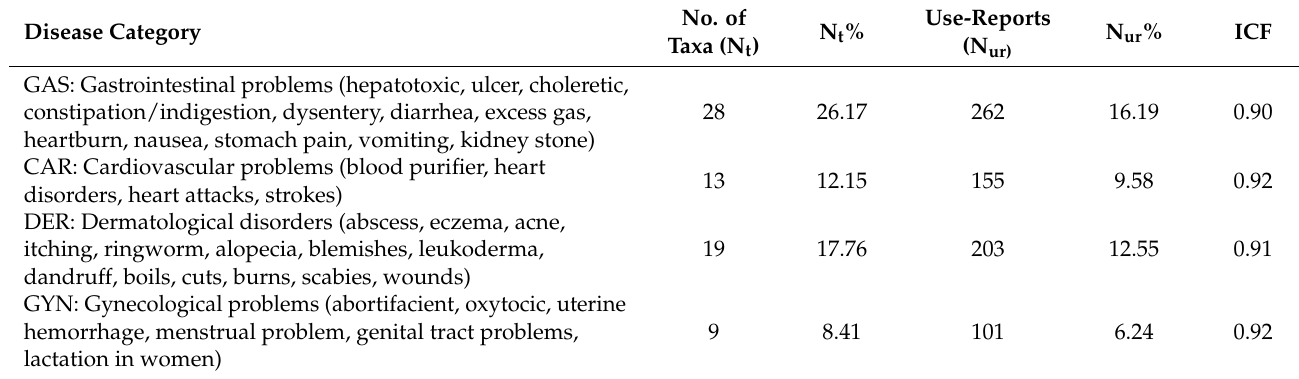
Table 5. Informant consensus factor (ICF) of common diseases prevalent in the study area. Disease